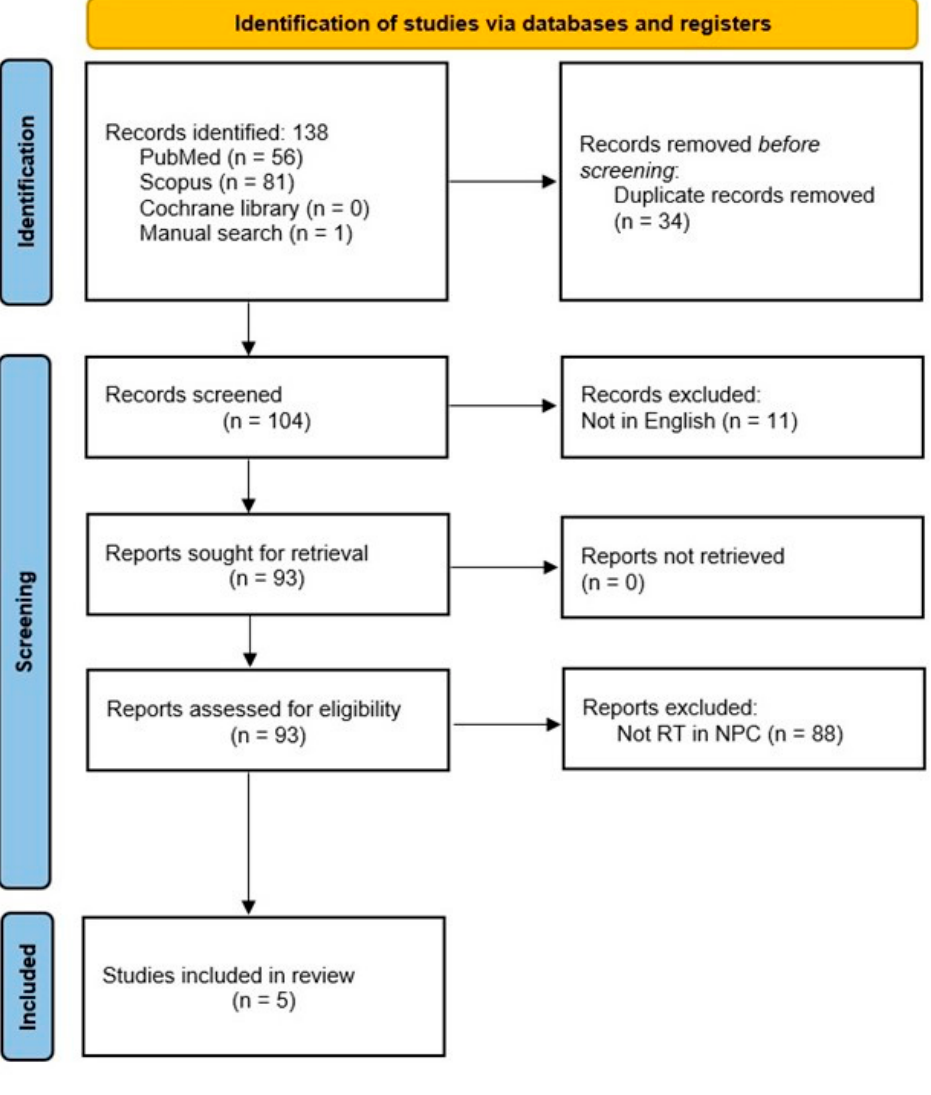
Figure 7. Search Strategy. Table 1. Main features of the studies included in the present systematic